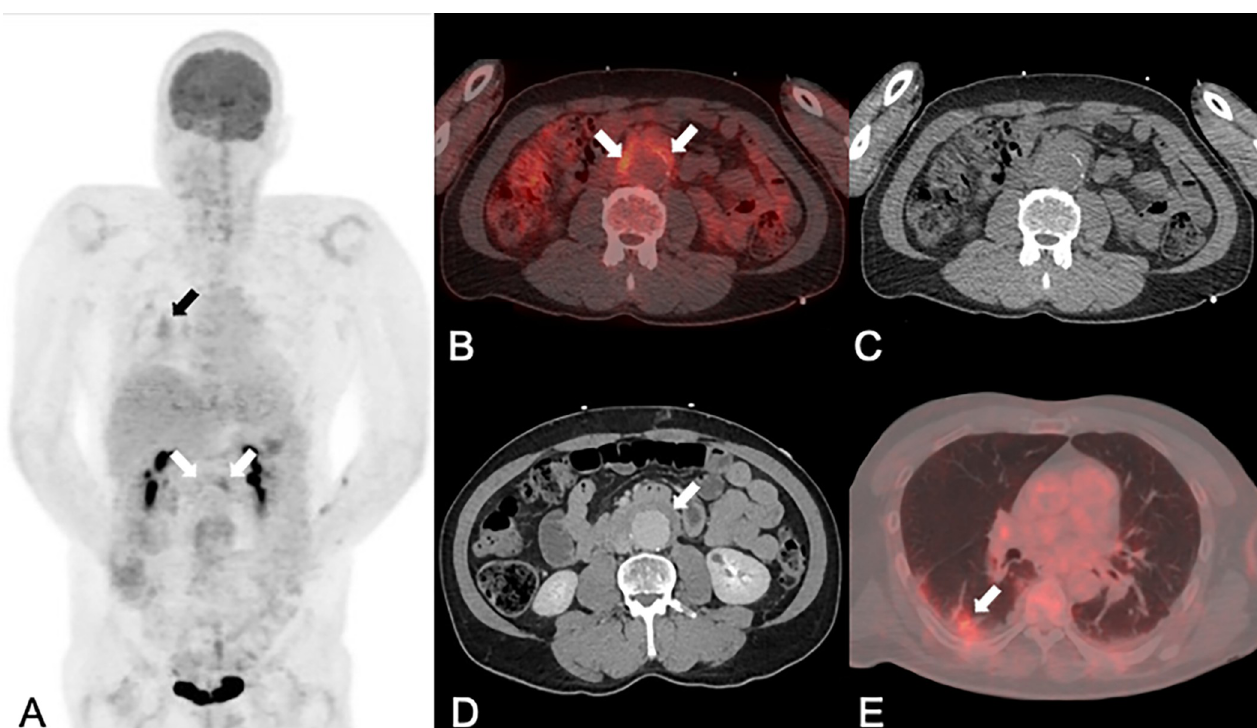
Fig 3. A 51-year-old man with an inflammatory abdominal aortic aneurysm, initially presenting with back pain and abdominal pain. PET/CT (A: maximum intensity projection of PET; B and E: fused PET/CT images) and contrast-enhanced CT (CE-CT: D) showed a 52 mm large abdominal aortic aneurysm (white arrows in B and D) with increased FDG uptake (SUVmax 3.6 in A and B) in the thickened (12 mm) aortic wall (white arrow in D) with dorsal sparing. Using PET/CT images alone (A-C) one reader correctly diagnosed an inflammatory aneurysm, while the other one falsely diagnosed an infectious/ mycotic aneurysm (notably, wall thickening may not be clearly delineated on the non-enhanced CT part of the PET/CT in C, but only on the CE-CT in D). With CE-CT (E) and with combined imaging (not shown) both readers correctly diagnosed an inflammatory aneurysm. As an incidental finding, a small metabolically active pneumonia was diagnosed on PET/CT images (E). The patient was subsequently treated with percutaneous endovascular abdominal aortic aneurysm repair and steroid therapy. The latest follow-up imaging five years after the initial diagnosis (not shown), showed a stable abdominal aortic graft with no relevant wall thickening, and the patient had no abdominal